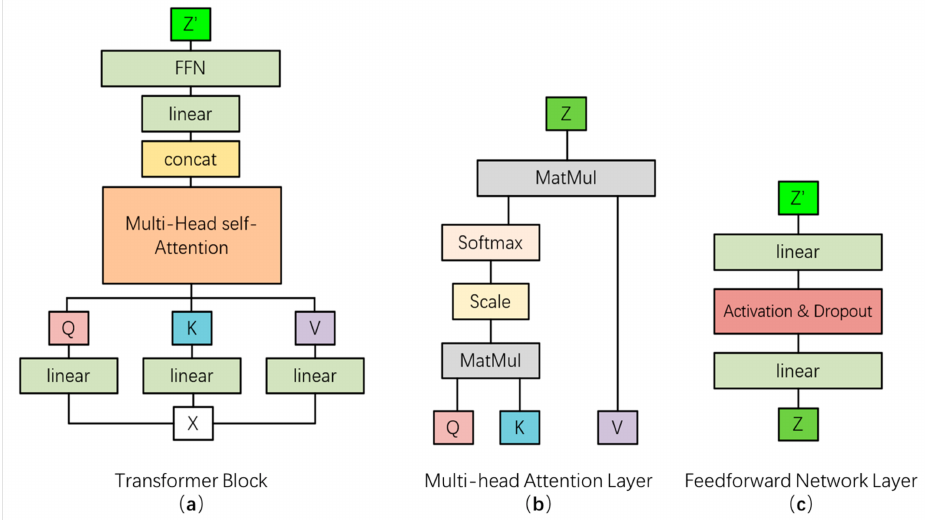
Figure 2. Structure of Transformer: ( a ) overall structure of Transformer, ( b ) Multi-head Attention Layer, ( c ) Feedforward Network Layer. X is the input of the Transformer layer, Z is the hidden feature space that the Transformer outputs, and Z’ is the output of the Transformer